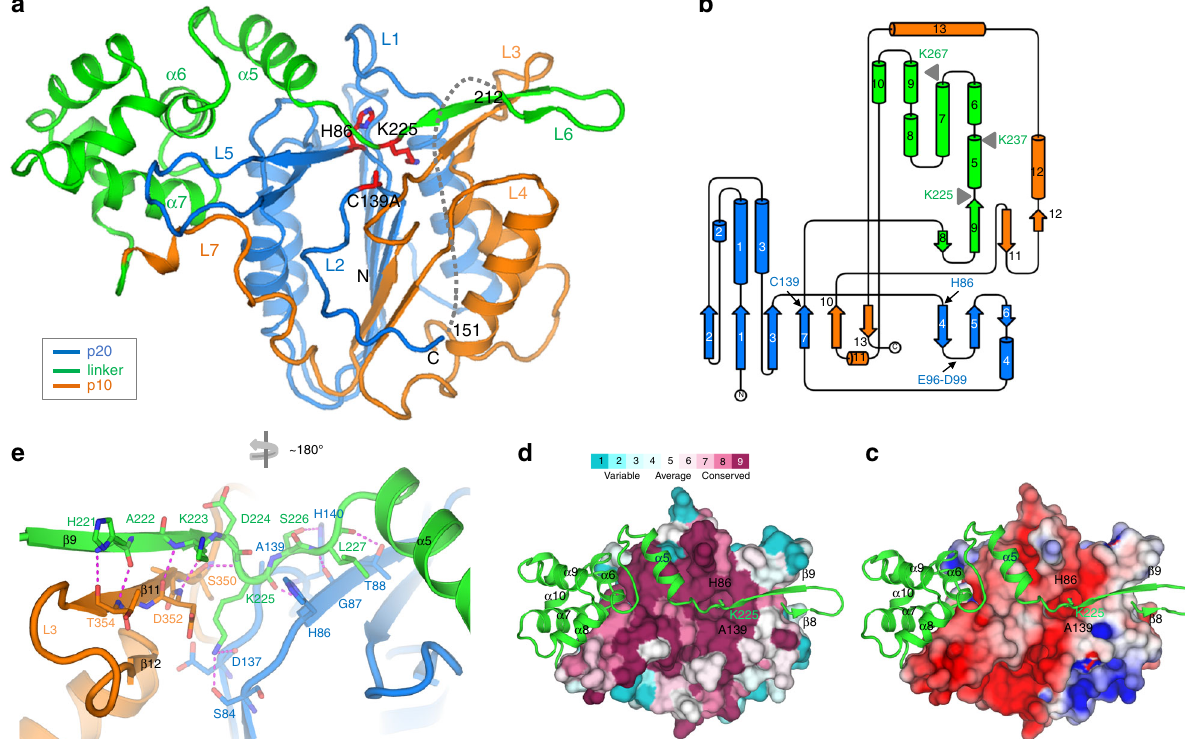
Fig. 1 Structure of At MC4 and self-inhibition mechanism. a At MC4 structure of a catalytically inactive C139A mutant. The three domains are shown as cartoons and are colored differently: p20 domain, marine; linker domain, green; p10 domain, orange. The catalytic dyad (C139A and His86) and a self- processing site (Lys225) are shown as sticks. Disordered region between residues 152 and 211 is shown as a dashed line. b Topological diagram for secondary structures of At MC4. Coloring is the same as ( a ). Locations of key residues discussed in the paper are indicated. c Electrostatics surface of the caspase-like core. The electrostatics was calculated by using program APBS 42 and plotted at the level of ±4 kT/e. d View of the linker domain attached on the surface of the caspase-like core with its Lys225 inserted in a conserved pocket. The conservation level is mapped to the surface: more conserved surfaces, more magenta; and more variable surfaces, more cyan. e Interactions between the Lys225 region and the caspase-like core. View in e is rotated approximately 180° relative to that of a